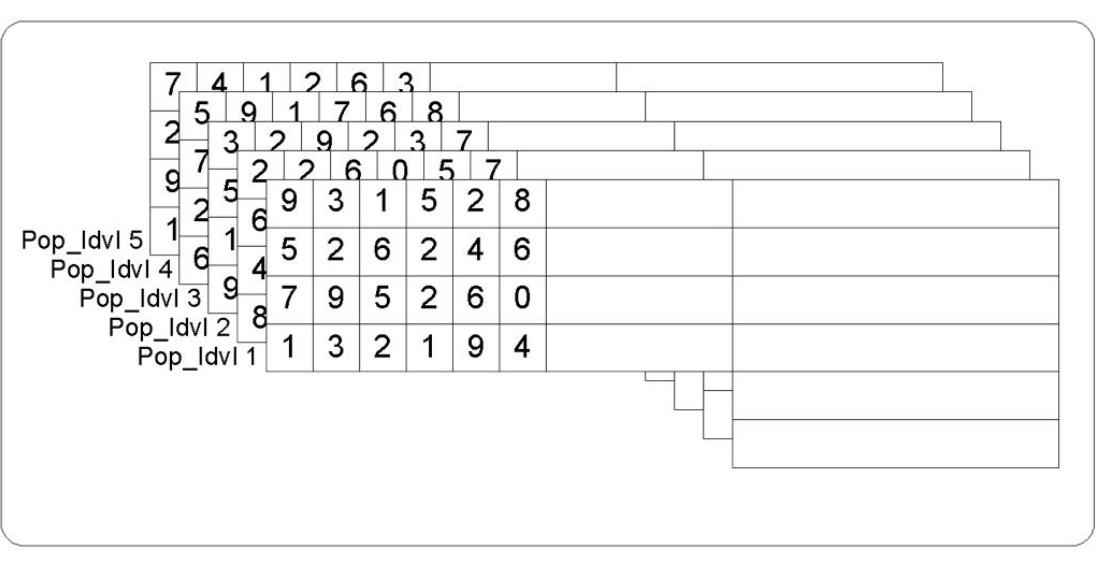
Figure 3: Random Population